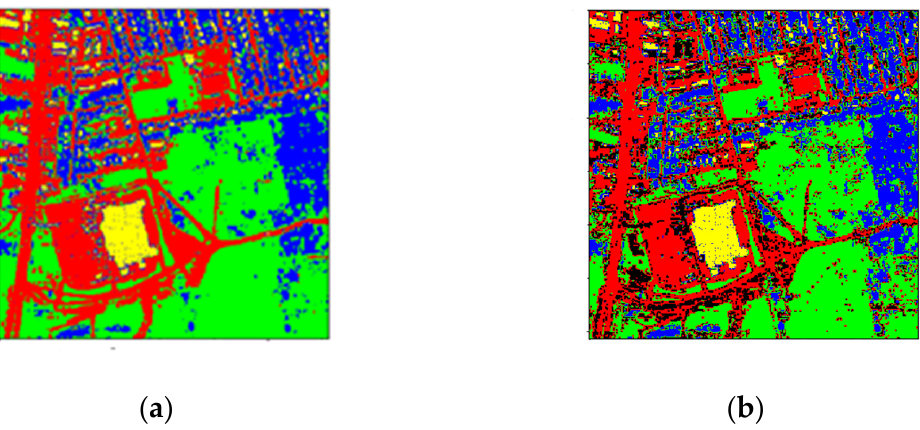
Figure 6. ( a ) Classified image of Gaussian maximum likelihood; ( b ) Result of comparison with the label image. Table 3. Accuracy of Gaussian Maximum Likelihood Classification. Asphalt